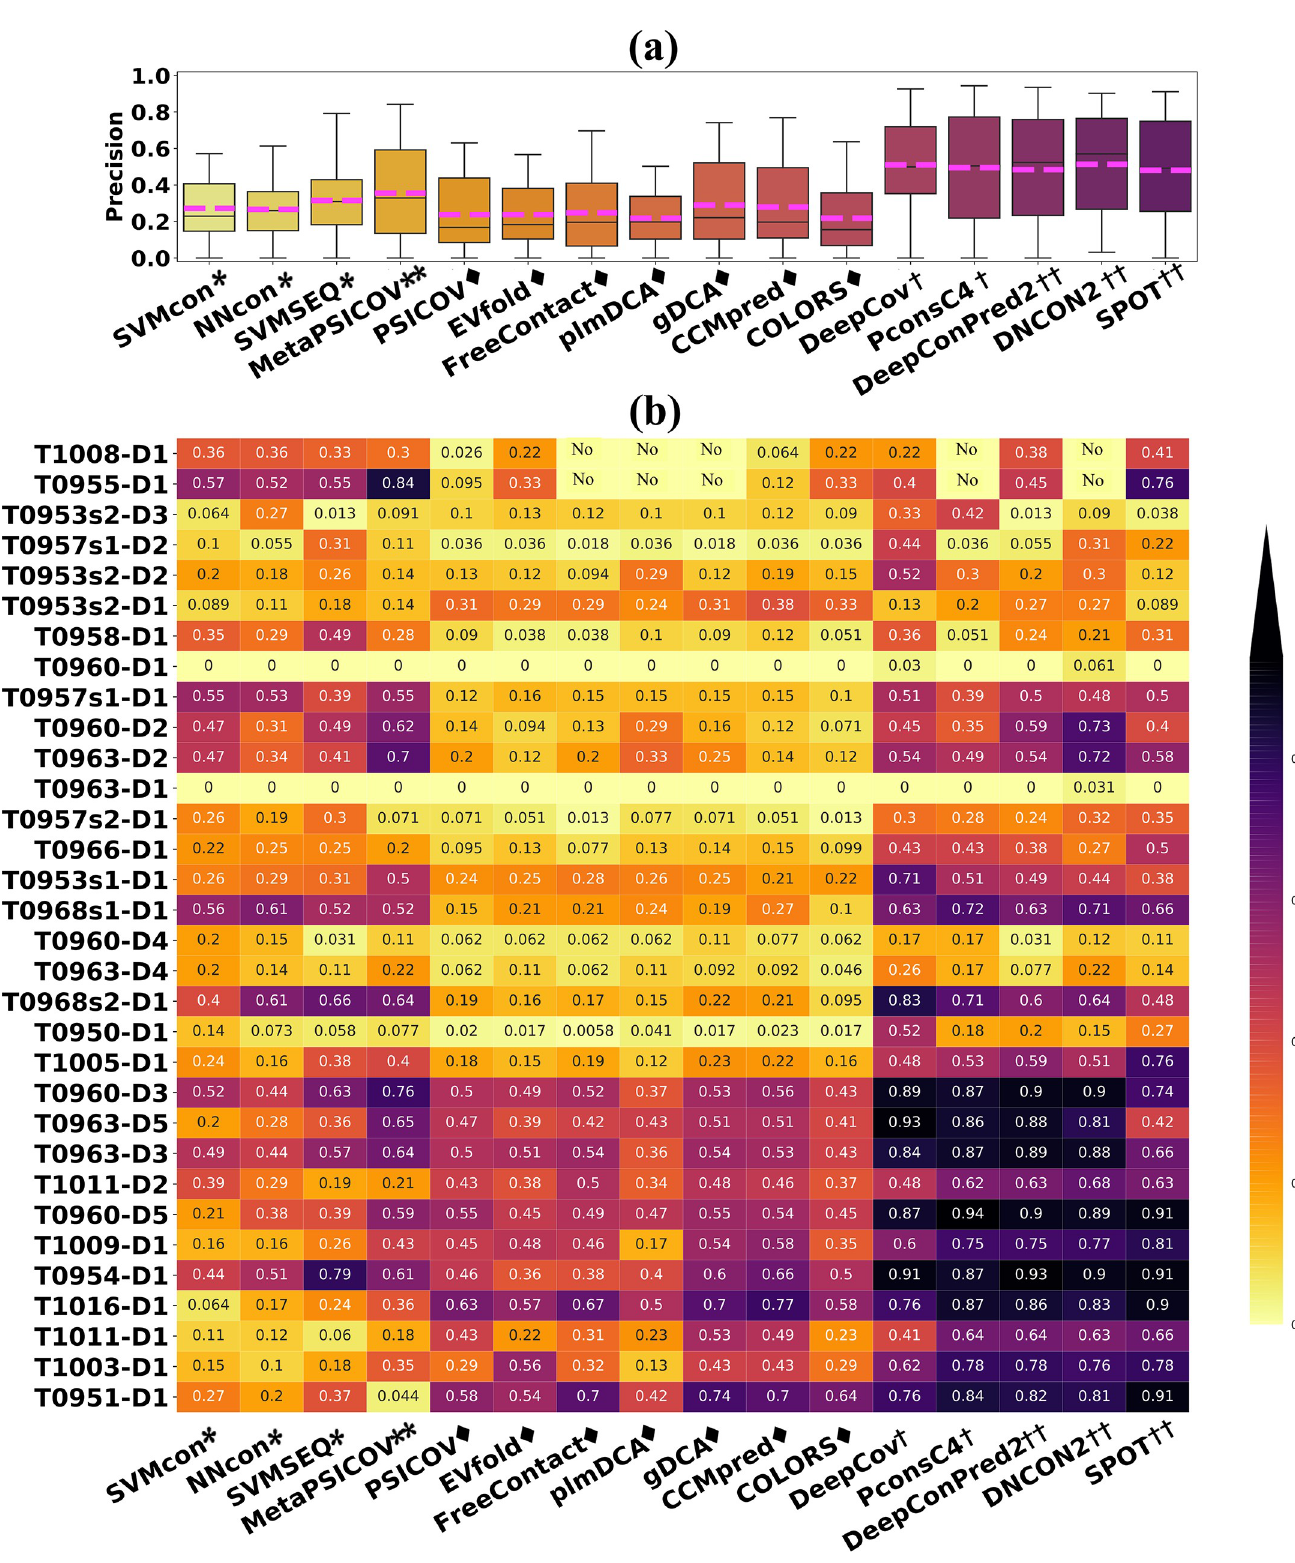
Fig 12. Prediction results for top L predictions of 32 CASP13 domains with sequence separation larger than 6. (a) The box plot of the overall prediction performance. The average prediction precision for each method is labeled with the pink dashed line. (b)The prediction precision distributions for each target of